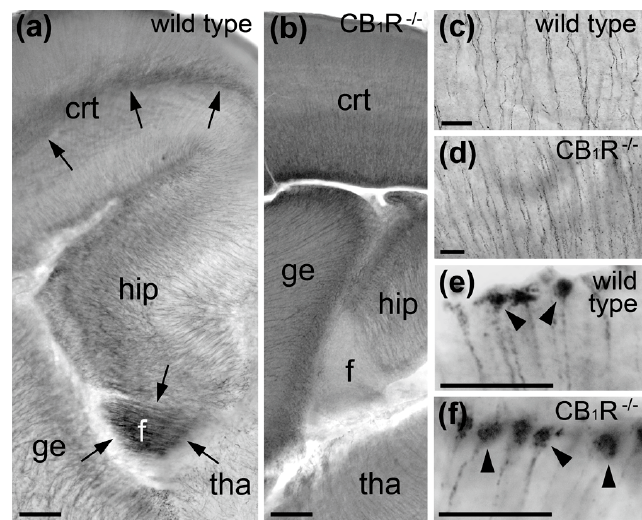
are underlined with white dotted lines. Abbreviations: f, fimbria; N, cell nucleus. Scale bars: ( a , c , d ) 100 μ m and ( b ) 1 μ m.